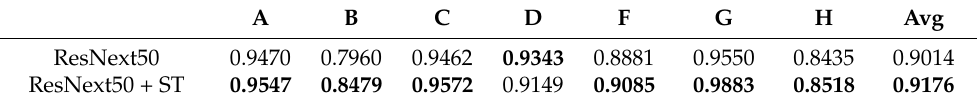
Table 2. Ablation results of self-training algorithm (bold means the best result).